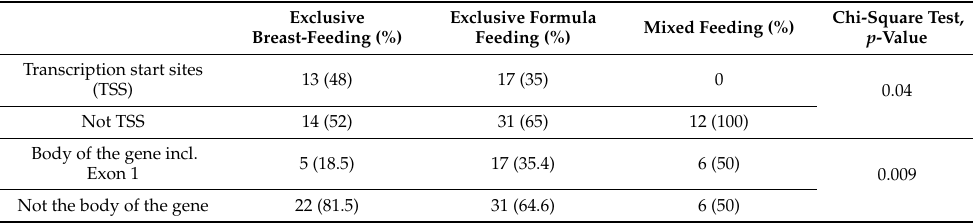
Table 5. Infant feeding mode and distribution of the CpG in different locations of the gene # . Exclusive Breast-Feeding